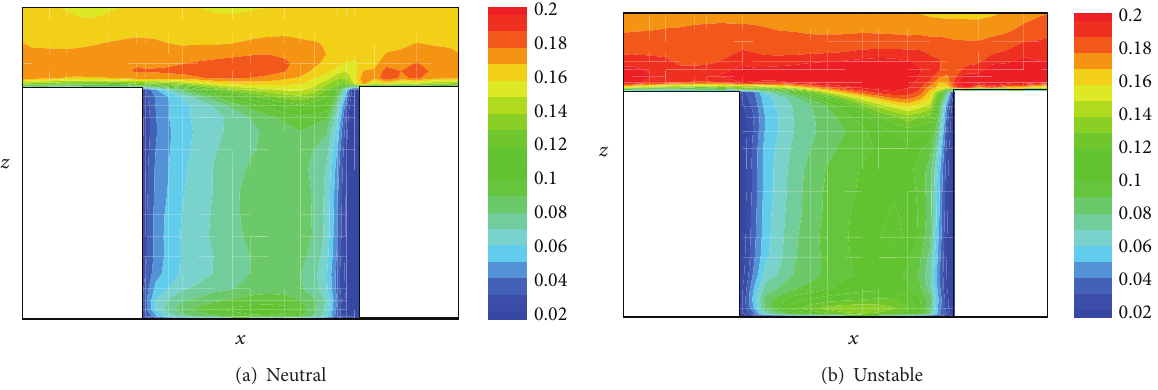
Figure 6: Contours of streamwise turbulence intensity 𝑢 the